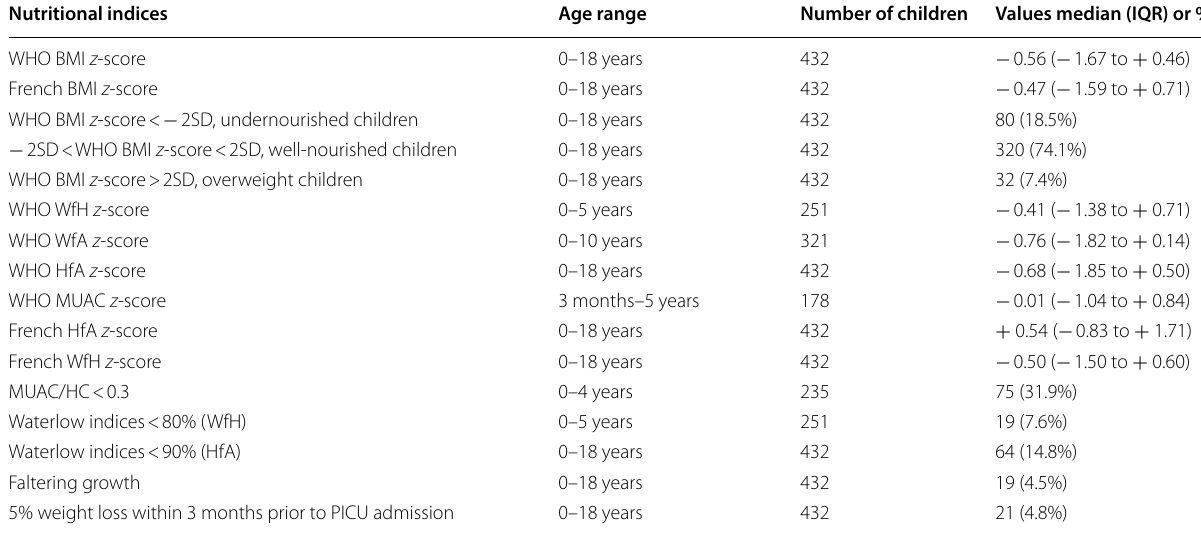
Table 5 Characteristics of patients according to undernutrition status (WHO standards)